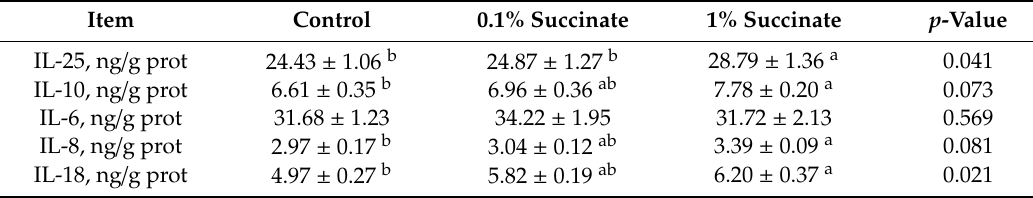
Table 6. E ff ects of diet sodium succinate supplementation on the protein abundances of inflammatory cytokines in the jejunum of pigs.